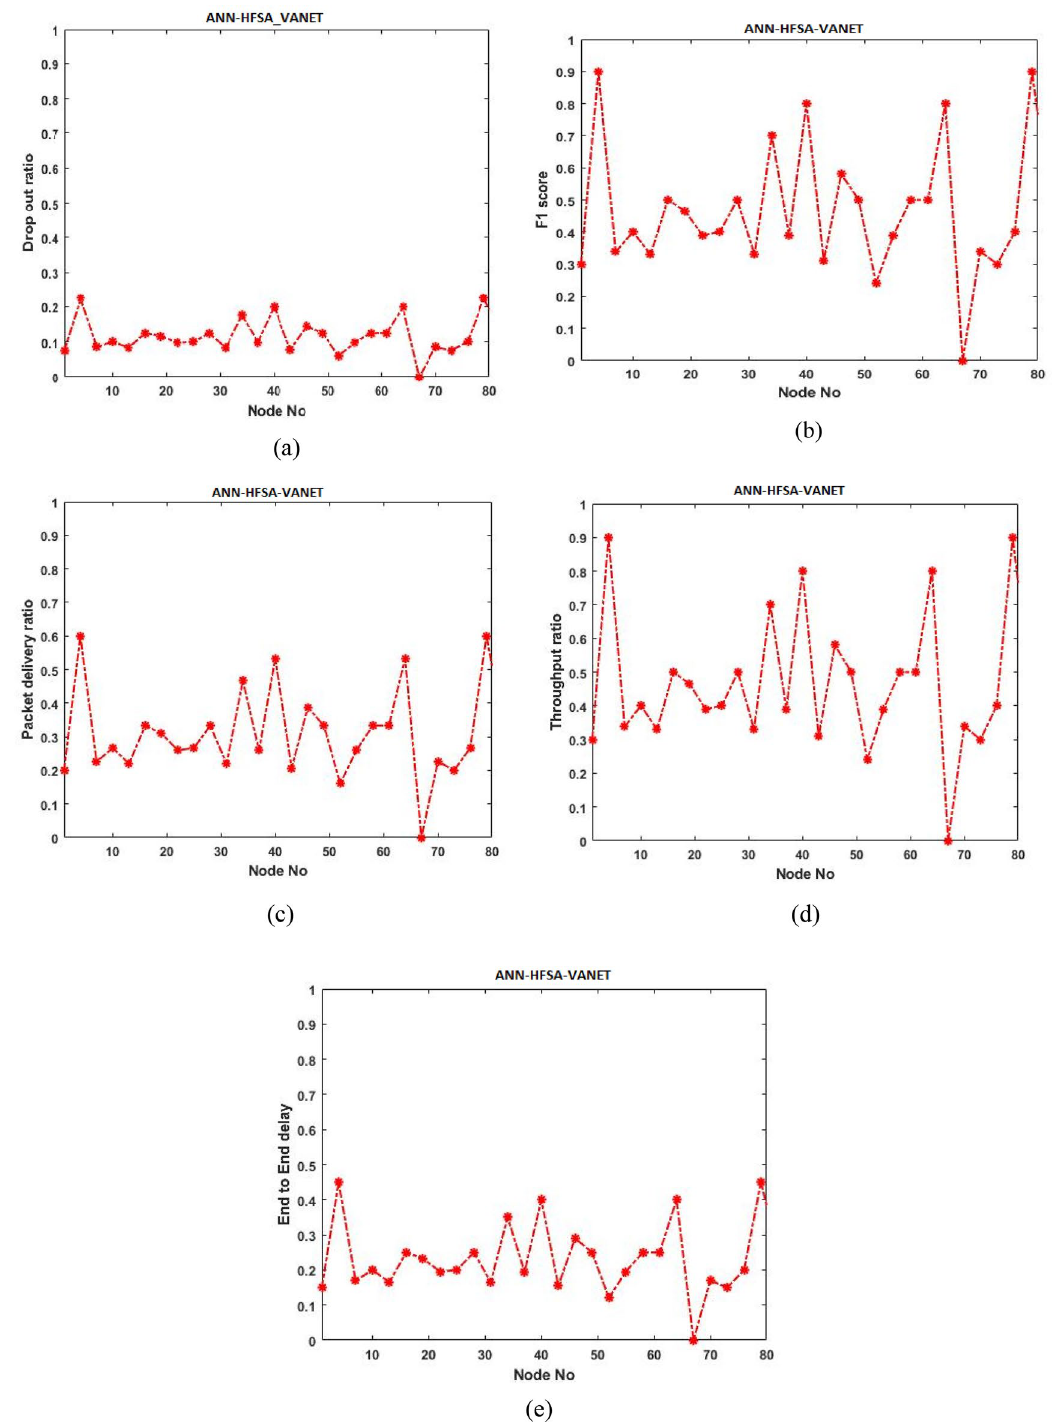
Figure 13. ( a ) Dropout ratio, ( b ) F1 score, ( c ) packet delivery ratio, ( d ) Throughput ratio, ( e ) End to end